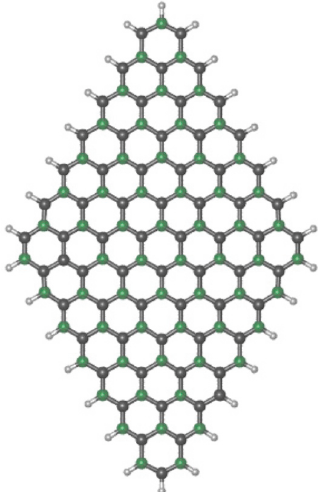
Figure 2: R 7 geometry: sublattice A in green; sublattice B in grey.